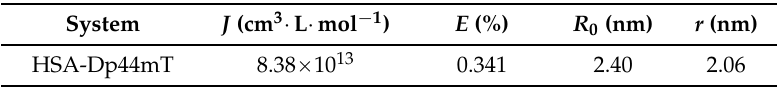
Table 5. The calculated values of J , r , R 0 , and E of HSA with Dp44mT.